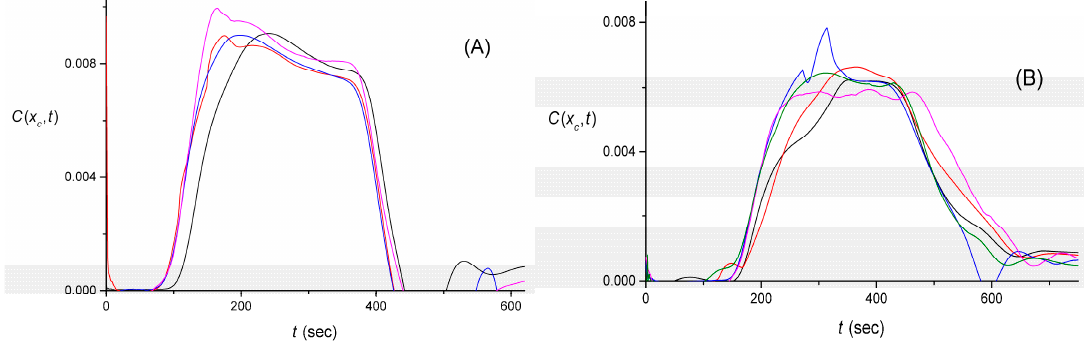
Figure 8. The input pulses, (cid:1829)((cid:1876) (cid:3030) , (cid:1872)) , in arbitrary units, generated from the signals, (cid:1845)((cid:1872)) , shown in Figure 1, after the latter were smoothed out as described in Section 4.3. The individual pulses are color coded with Figure 1. ( A ) Four different rectangular input pulses; ( B ) Five different triangular input pulses. Both sets were obtained without the enzyme-catalyzed process being activated.